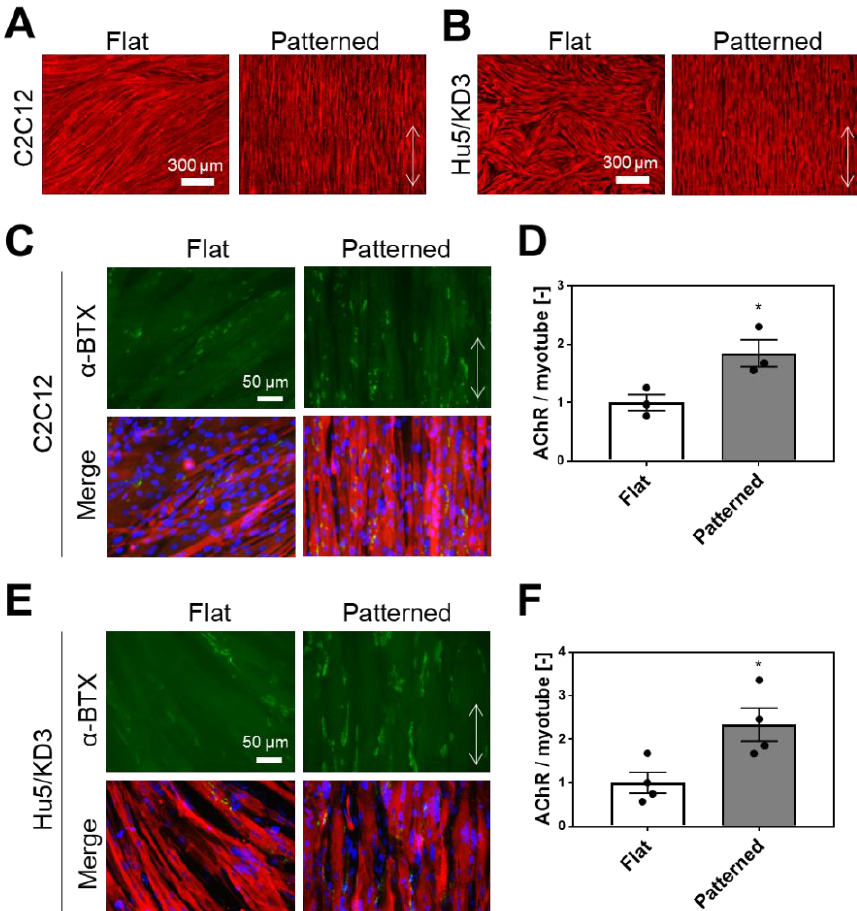
Figure 1. Alignment and AChR clustering of SkM cells cultured on the surface with linear grooves. Immunofluorescence staining of ( A ) C2C12 and ( B ) Hu5/KD3 myotube cultured on the flat or pat- terned surface. Red indicates α -actinin. Scale bar: 300 µ m. Fluorescence staining of AChR clustering in ( C ) C2C12 and ( E ) Hu5/KD3 myotube cultured on the flat or patterned surface. Green indicates AChR clustering, red indicates α -actinin, and blue indicates nuclei. Scale bar: 50 µ m. Number of AChR clustering in ( D ) C2C12 or ( F ) Hu5/KD3 myotubes. Data points represent means ± SD ( n = 3–4). Double arrow indicates the direction of linear grooves. * p < 0.05. The formation of AChR clusters was visualized using fluorescently labeled α